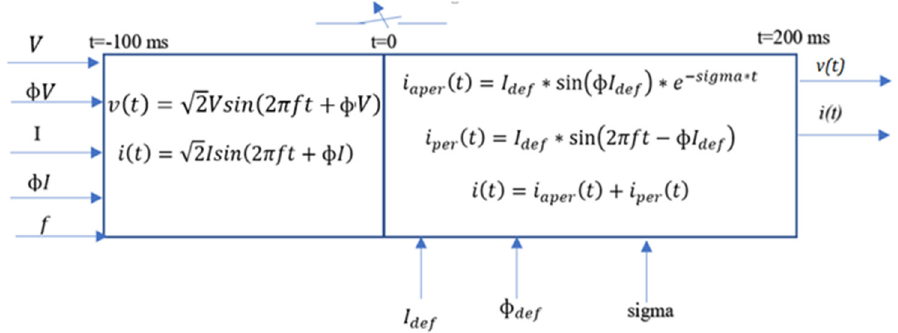
Figure 4. The mathematical model used [1].